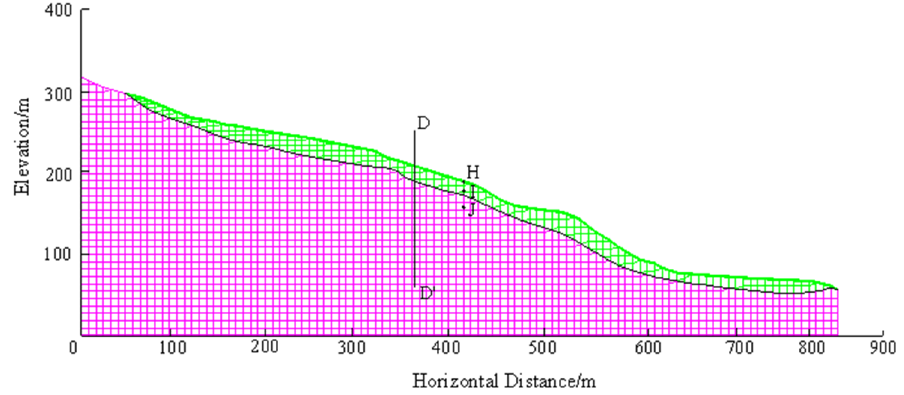
Figure 4. Finite element grid diagram of the slope cross-section.